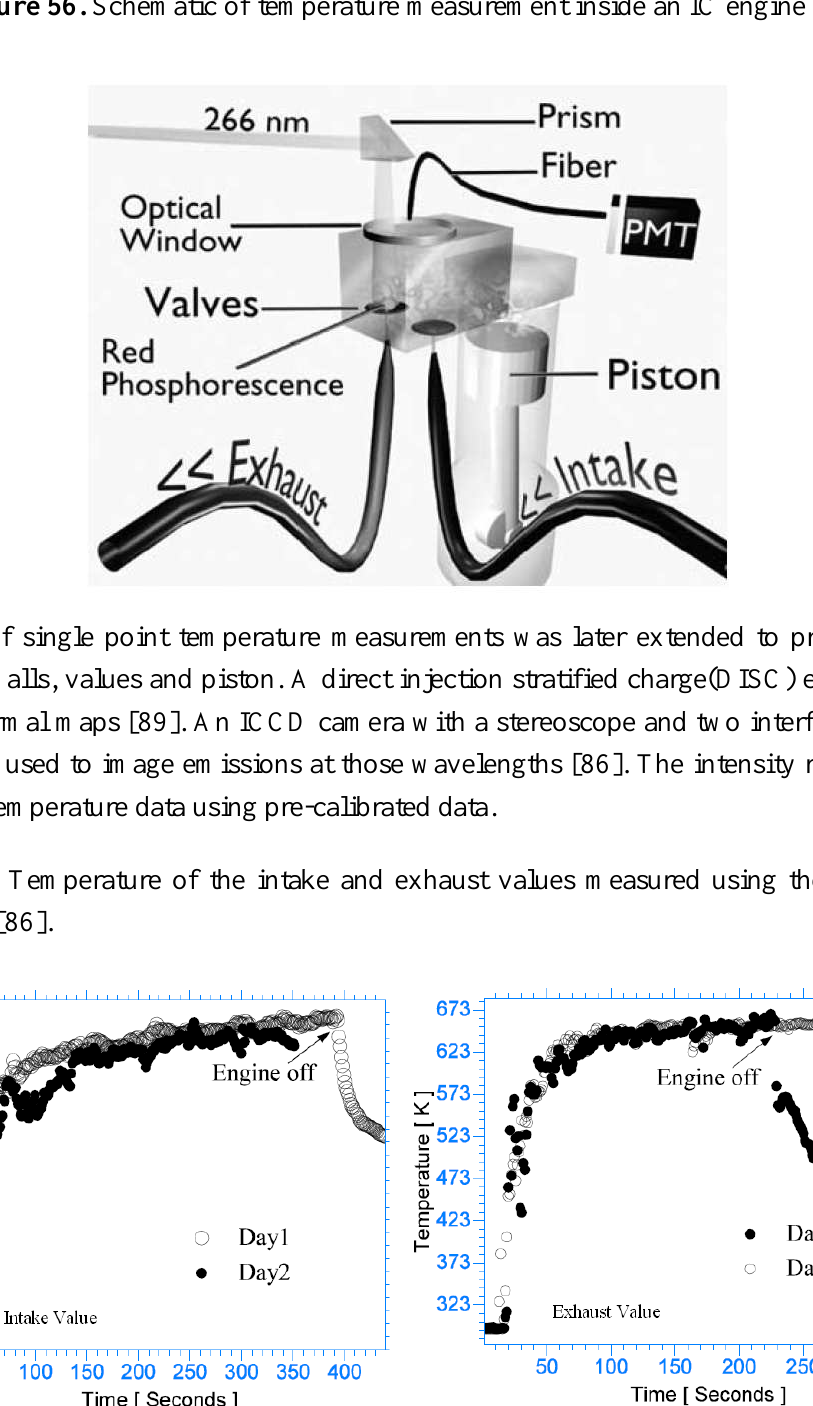
Figure 56. Schematic of temperature measurement inside an IC engine